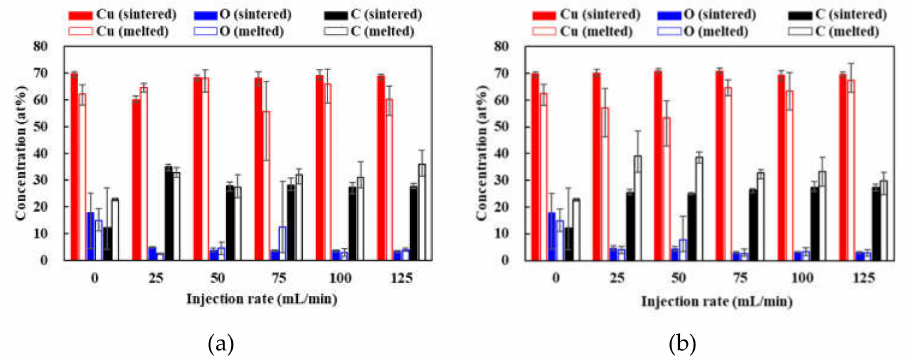
Figure 7. Concentration ratio of the patterns in sintered and melted area under ( a ) N 2 and ( b ) Ar gas injections.